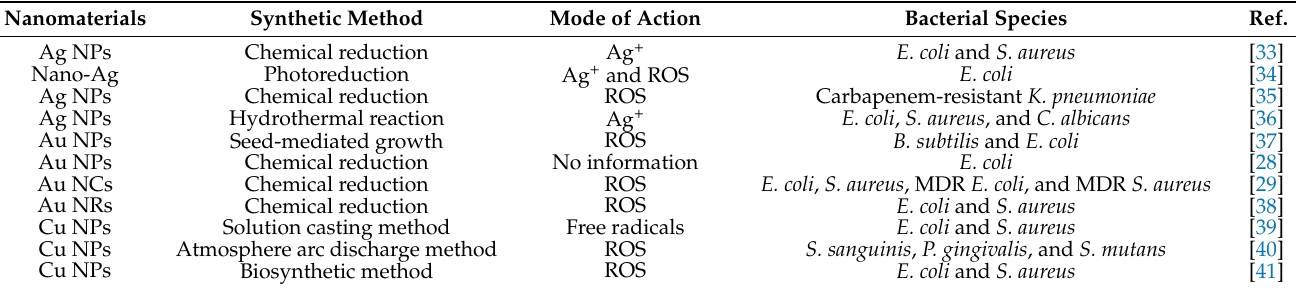
Table 1. The antibacterial mechanism and synthetic method of metal nanomaterials.